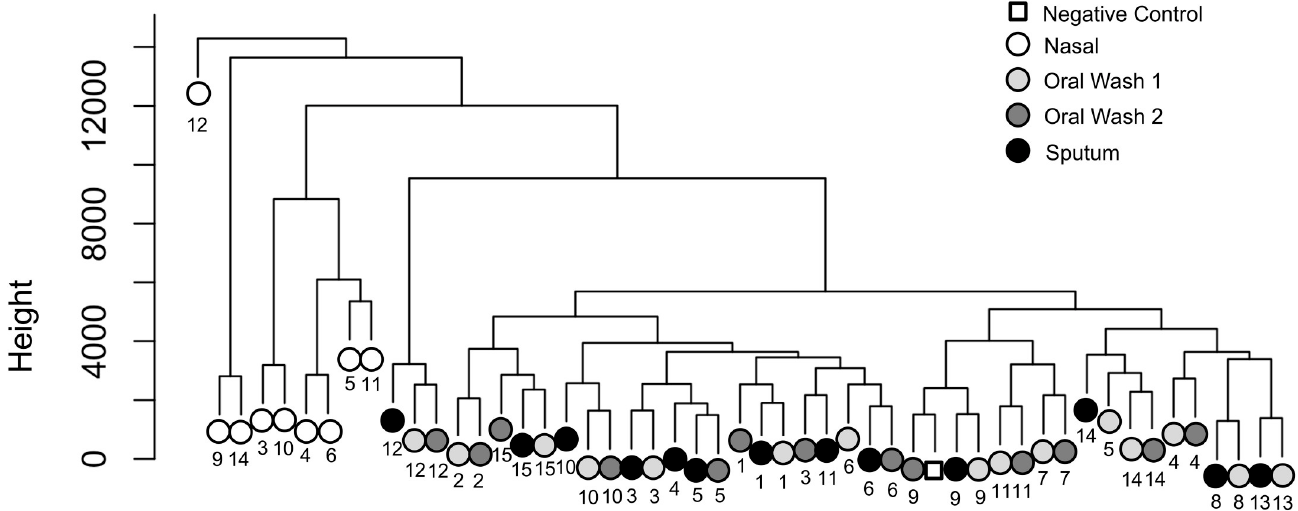
Fig 5. Nasal samples are distinct from the combined oral wash and sputum samples. Hierarchical clustering was performed using the hclust function after filtering the dataset as described in the text. Nasal samples cluster together at left, while oral wash samples and sputum samples are intermixed at right. In many cases, the two oral wash samples from the same subject are the nearest neighbors, although sputum samples are often closely associated with one of the oral wash samples from the same subject. Subjects are identified by number and sample type is indicated by color (see legend).